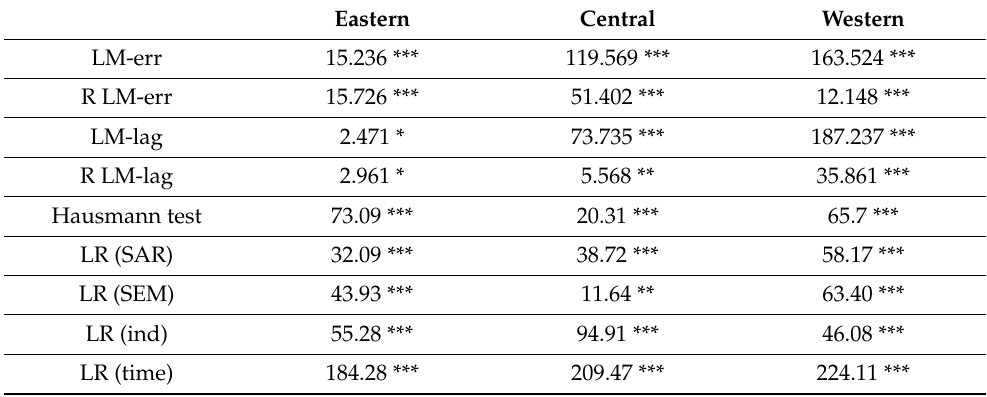
Table 6. Model selection in different regions. Eastern Central Western LM-err 15.236 *** 119.569 *** 163.524